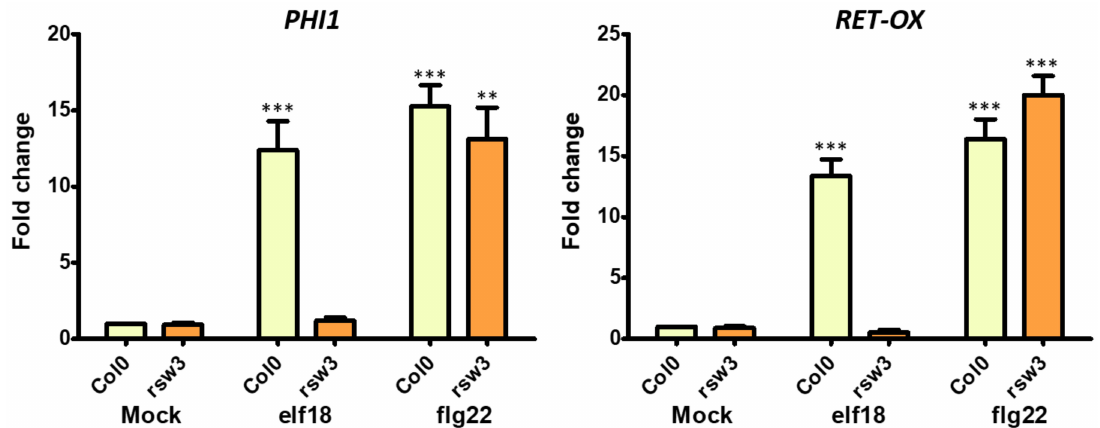
Figure 3. Expression of defence genes in the At rsw3 plant. 10-day-old seedlings were treated with water or elf18 and flg22 elicitors. Expression of phosphate-induced 1 ( PHI-1 ) and reticulin-oxidase homologue ( RET-OX ) genes were determined by quantitative reverse transcription-PCR (qRT-PCR) 30 min after treatment. Transcript levels are shown as the mean of at least three independent experiments ( ± s.e. n = 20 in each experiment) normalized to ubiquitin 5 ( UBQ5) used as a reference. In both panels, asterisks indicate statistically significant differences among mock and treatments within the same genotype (same color) according to Student’s t -test (* = p < 0.5, ** = p < 0.01, *** = p <